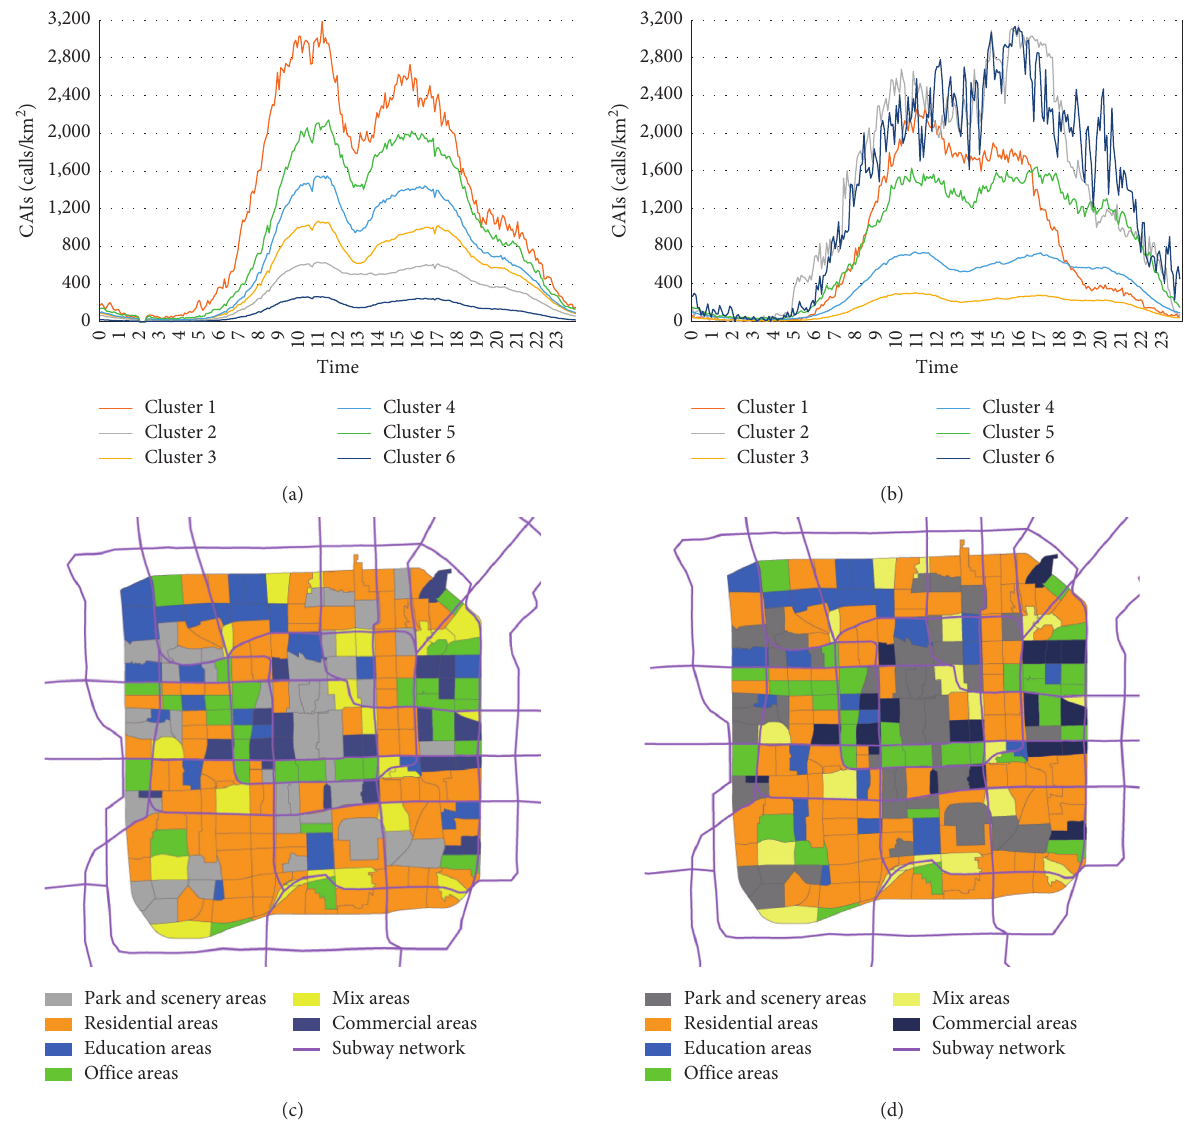
Figure 3: Results of CDR data clustering: (a) clustering results on weekday, (b) cluster results on weekend, (c) spatial distribution of six clusters on weekdays, and (d) spatial distribution of six clusters on